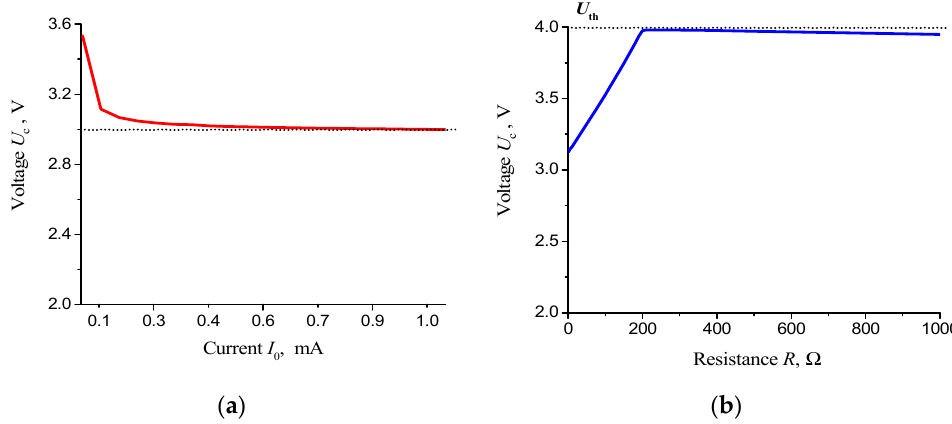
Figure 4. The dependence of DC component U c of OSC1 ( a ) and OSC2 ( b ) on the supply current I 0 and variable resistance R , respectively.